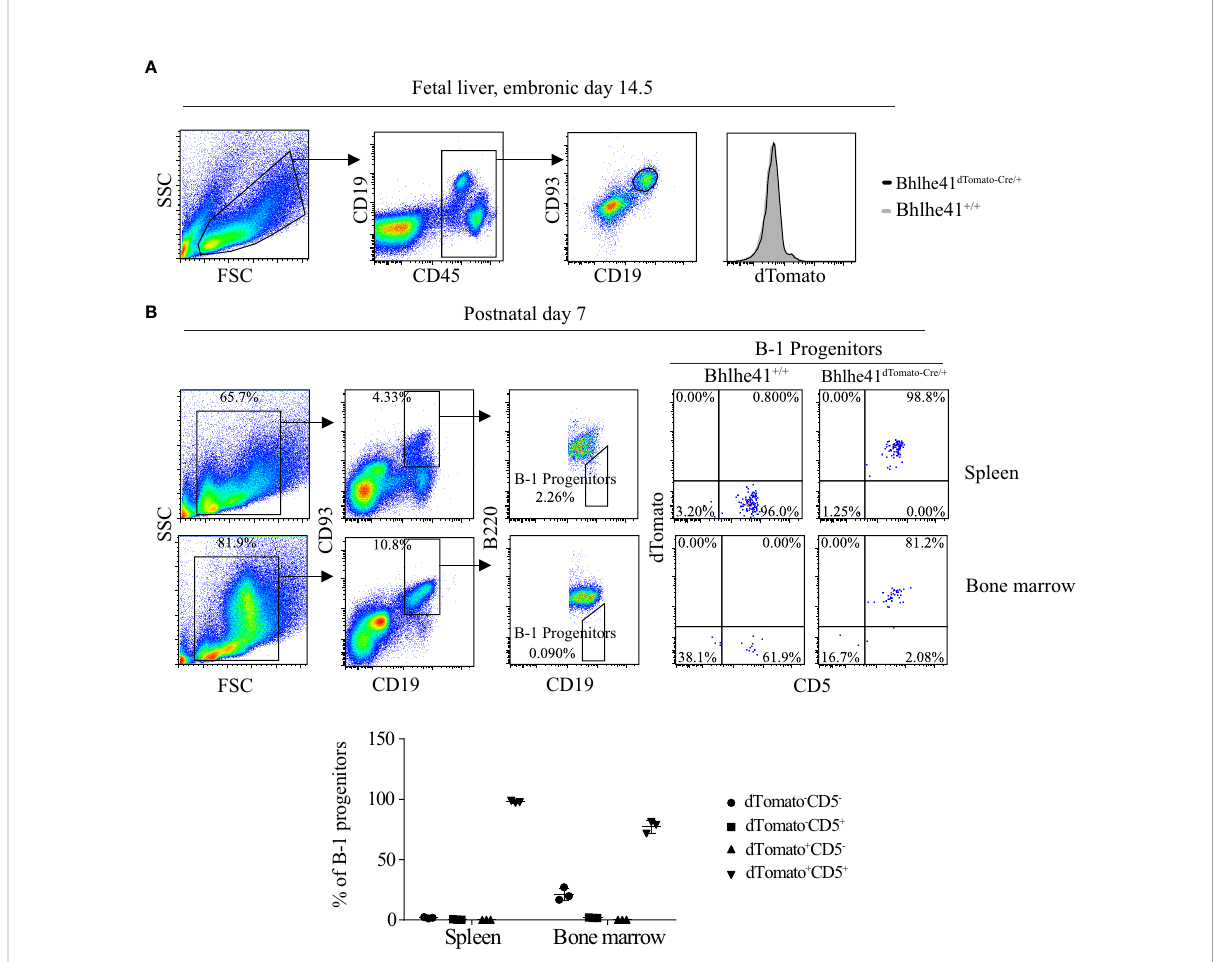
FIGURE 2 Identi fi cation of neonatal B-1 progenitors as transitional B-1a progenitors that highly express Bhlhe41 using Bhlhe41 dTomato-Cre mice. Flow cytometric analysis of dTomato expression in (A) B cells in fetal liver from Bhlhe41 +/+ and Bhlhe41 dTomato-Cre/+ mice at embryonic day 14.5